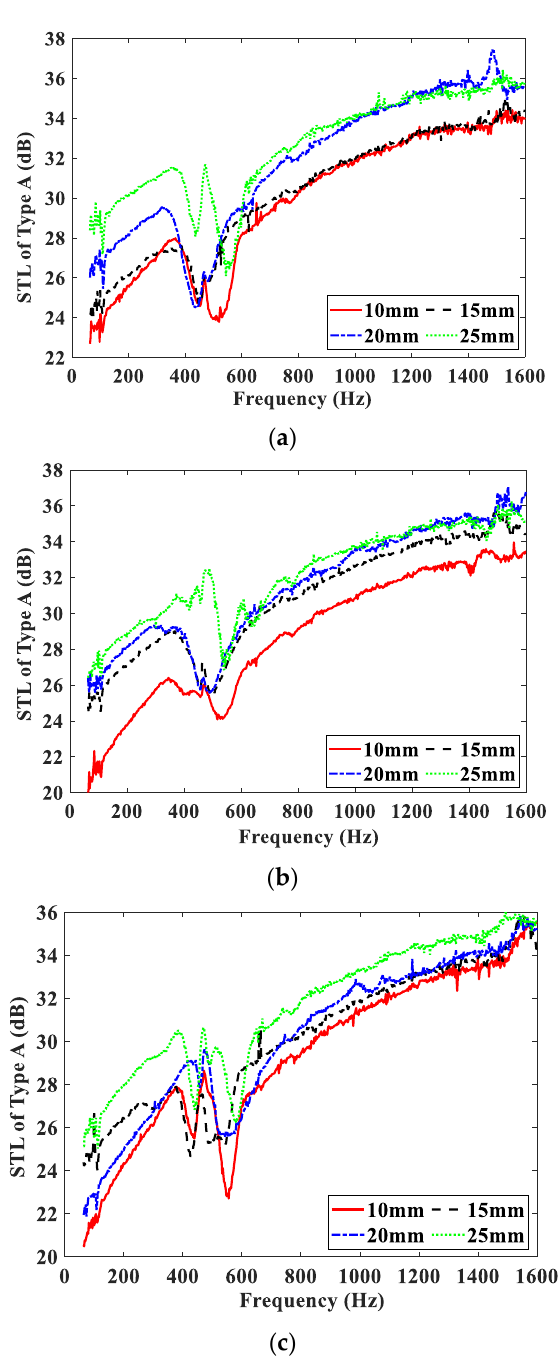
Figure 6. STL curves of Type A test samples under different magnetic field intensities. ( a ) Embedded with MRF unit; ( b ) embedded with air unit; ( c ) embedded with water unit.